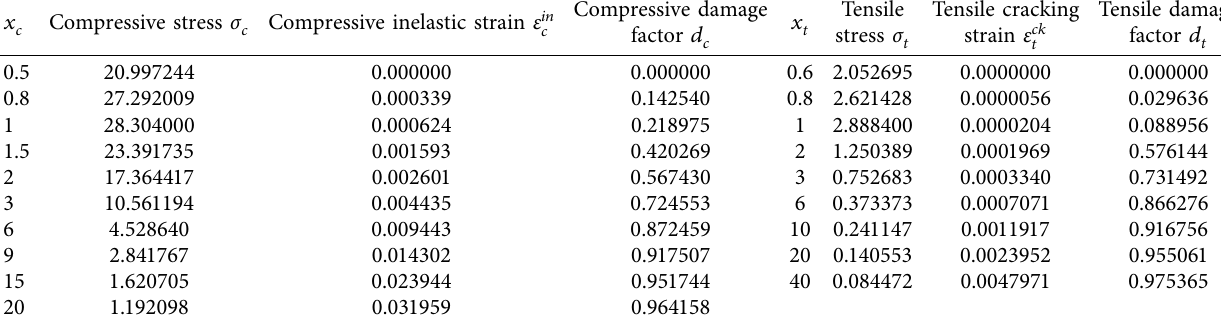
Table 6: Parameters of concrete mechanical behavior.